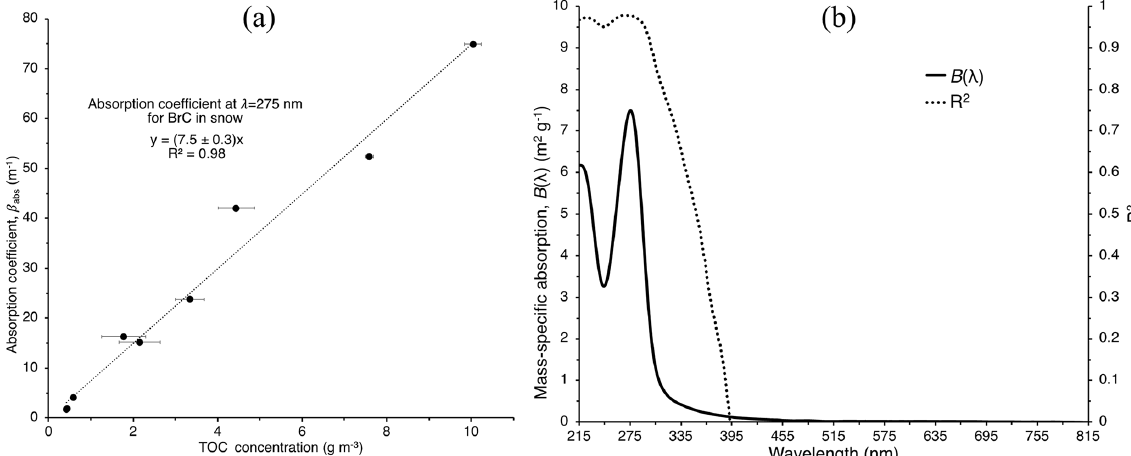
Figure 5. (a) Absorption coefficient at 275nm as a function of total organic carbon (TOC) concentration. The fitted linear regression slope gives the mass-specific absorption B λ = 7 . 5 ± 0 . 3m 2 g − 1 with a correlation coefficient of R 2 = 0 . 98. (b) Mass-specific absorption, B(λ) , and R 2 for each value of B(λ) across the wavelength range 215–815nm for BrC deposited experimentally and found in natural snow at Tamarack Lake together at a 1nm resolution. These panels include absorption coefficients of all meltwater samples characterized in Fig. 2.